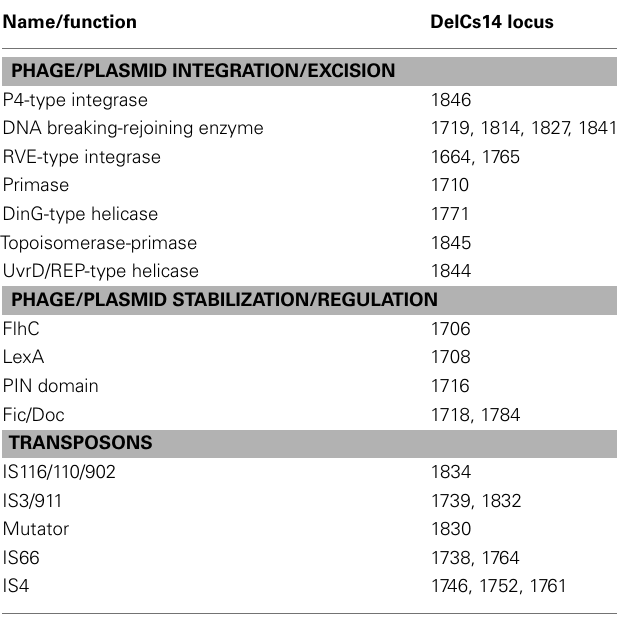
Table 2 | Genes encoding DNA mobilization